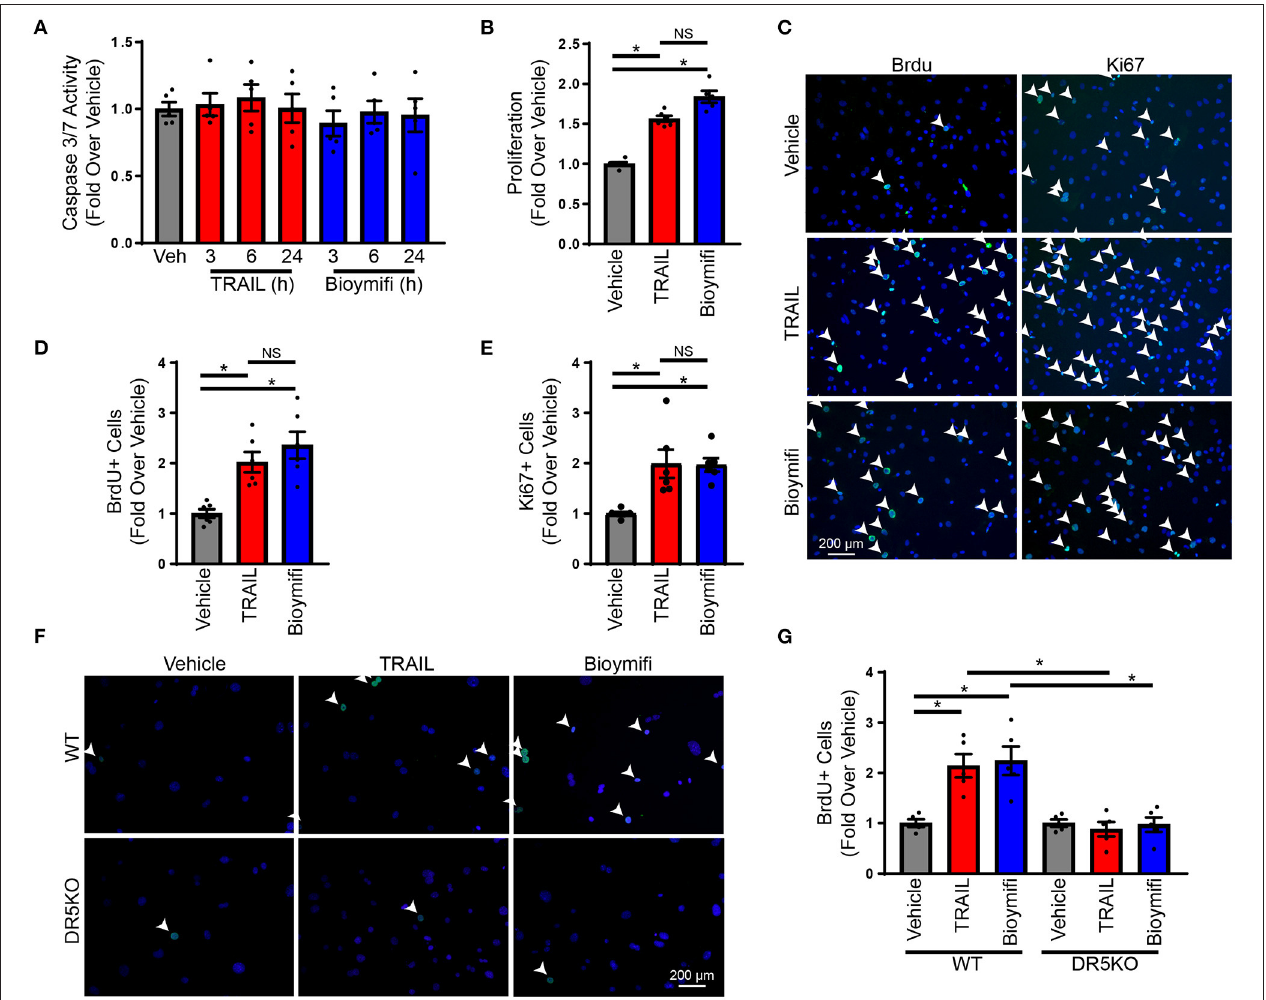
FIGURE 1 | DR5 activation induces proliferation in cardiac fibroblasts. (A) A caspase 3/7 assay was used to measure the induction of apoptosis in NRVFs treated over time with TRAIL, bioymifi, or vehicle control. N = 5. (B) An MTS assay was used to measure proliferation in vehicle, TRAIL, or bioymifi treated NRVFs. n = 6, One-Way ANOVA, * p < 0.05. (C) Representative BrdU and Ki67 staining (green) and quantified BrdU (D) or Ki67 (E) staining for vehicle, TRAIL, or bioymifi treated NRVFs. Cells were counterstained with DAPI (blue) to identify nuclei. White arrows indicate BrdU-positive nuclei. n = 6, One-Way ANOVA, * p < 0.05. Representative (F) and quantified (G) BrdU staining (green) in WT and DR5KO AMCF treated with TRAIL, bioymifi, or vehicle control. DAPI (blue) was used to identify nuclei. White arrows indicate BrdU-positive nuclei. n = 5, Two-Way ANOVA, * p <